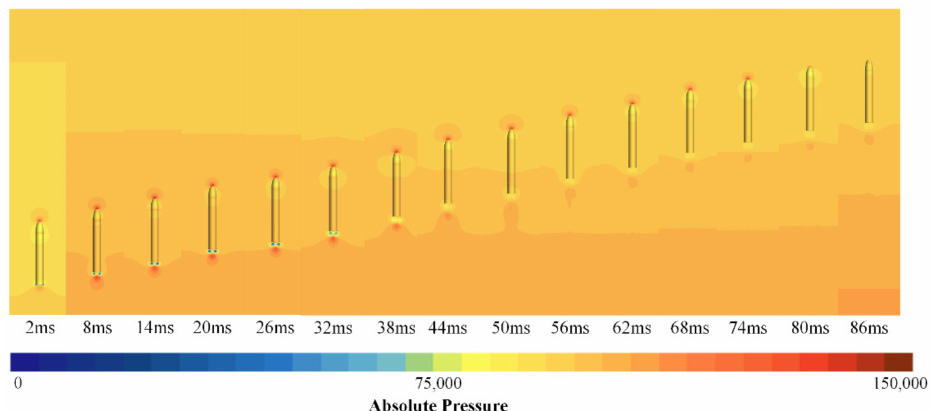
Figure 15. Pressure distribution in the computational domain at different